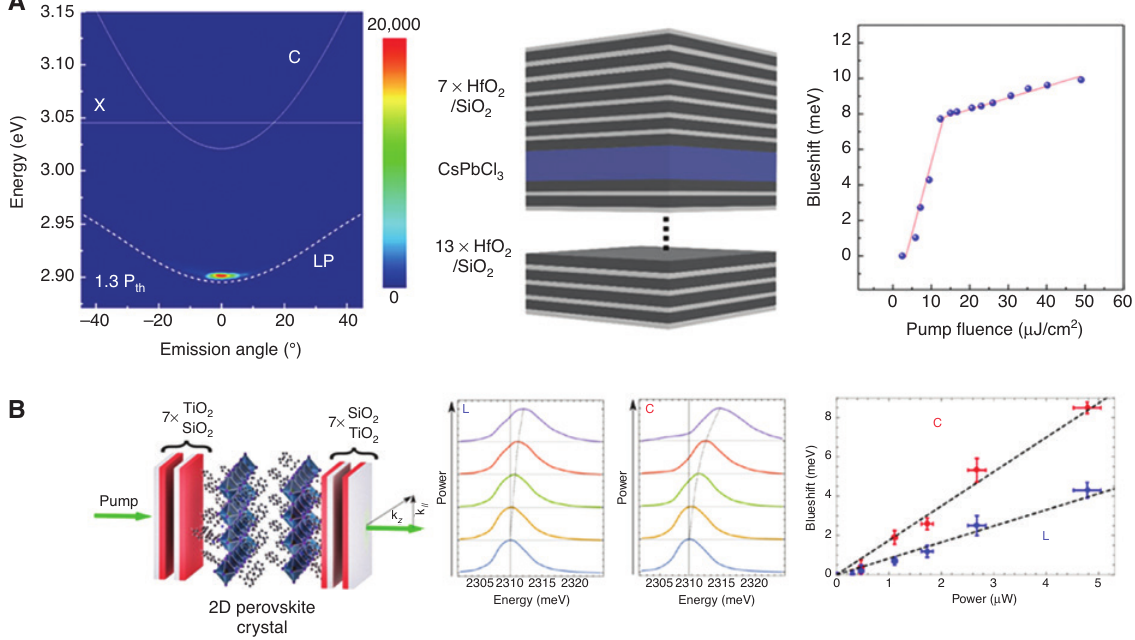
Figure 7: Polariton condensation and nonlinearities in PVKs based microcavities. (A) Polariton condensation in a CsPbCl crystalline nanoplatelet embedded in a planar microcavity formed by a bottom and a top HfO 3 DBR. Energy blueshift (on the right) with respect to the polariton emission energy at the lowest pump fluence as a function of pump fluence [79]. (B) Schematic representation of a 2D PVK single crystal embedded in an optical cavity formed by two DBRs and transmittivity spectra corresponding to different resonant excitation power for linear and circular polarized excitation laser; blueshift (right) of the polariton modes in the case of a linear (L) and a circular (C) polarized laser